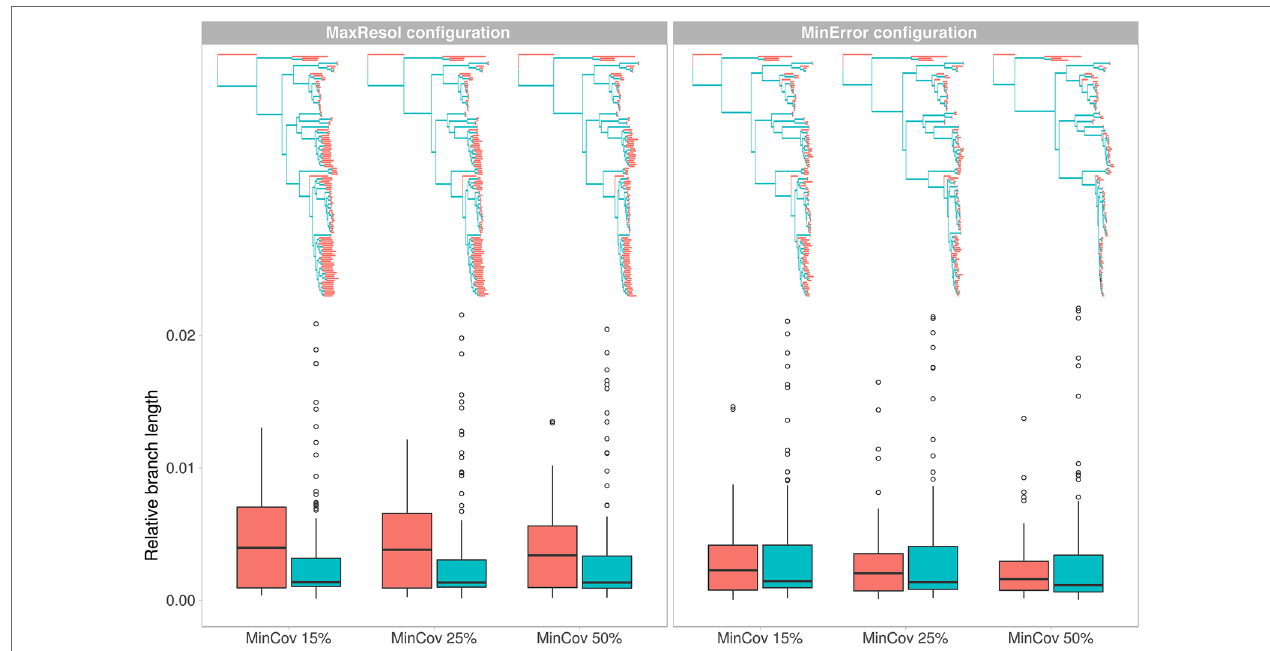
FIGURE 4 | Phylogenetic trees and variation in relative branch lengths (shown as boxplots) resulting from two extreme parameter configurations (MaxResol, maximizing phylogenetic resolution; and MinError, minimizing allele and SNP error rates) under three minimum taxon coverage percentages (MinCov 15%, 25%, and 50%) used in the assembly of GBS data of Helianthemum . Red represents terminal branches while blue represents internal branches.